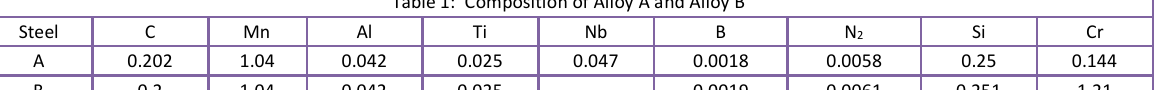
Table 1: Composition of Alloy A and Alloy B